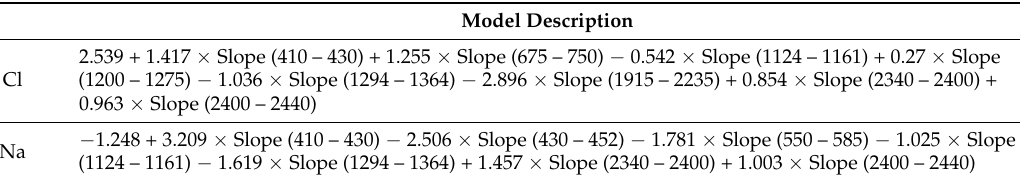
Figure 4. Slope value distribution of all samples, and for tomato and cotton separately, for 14 spectral ranges. Table 3. Prediction models for Cl and Na using the slope-based method.